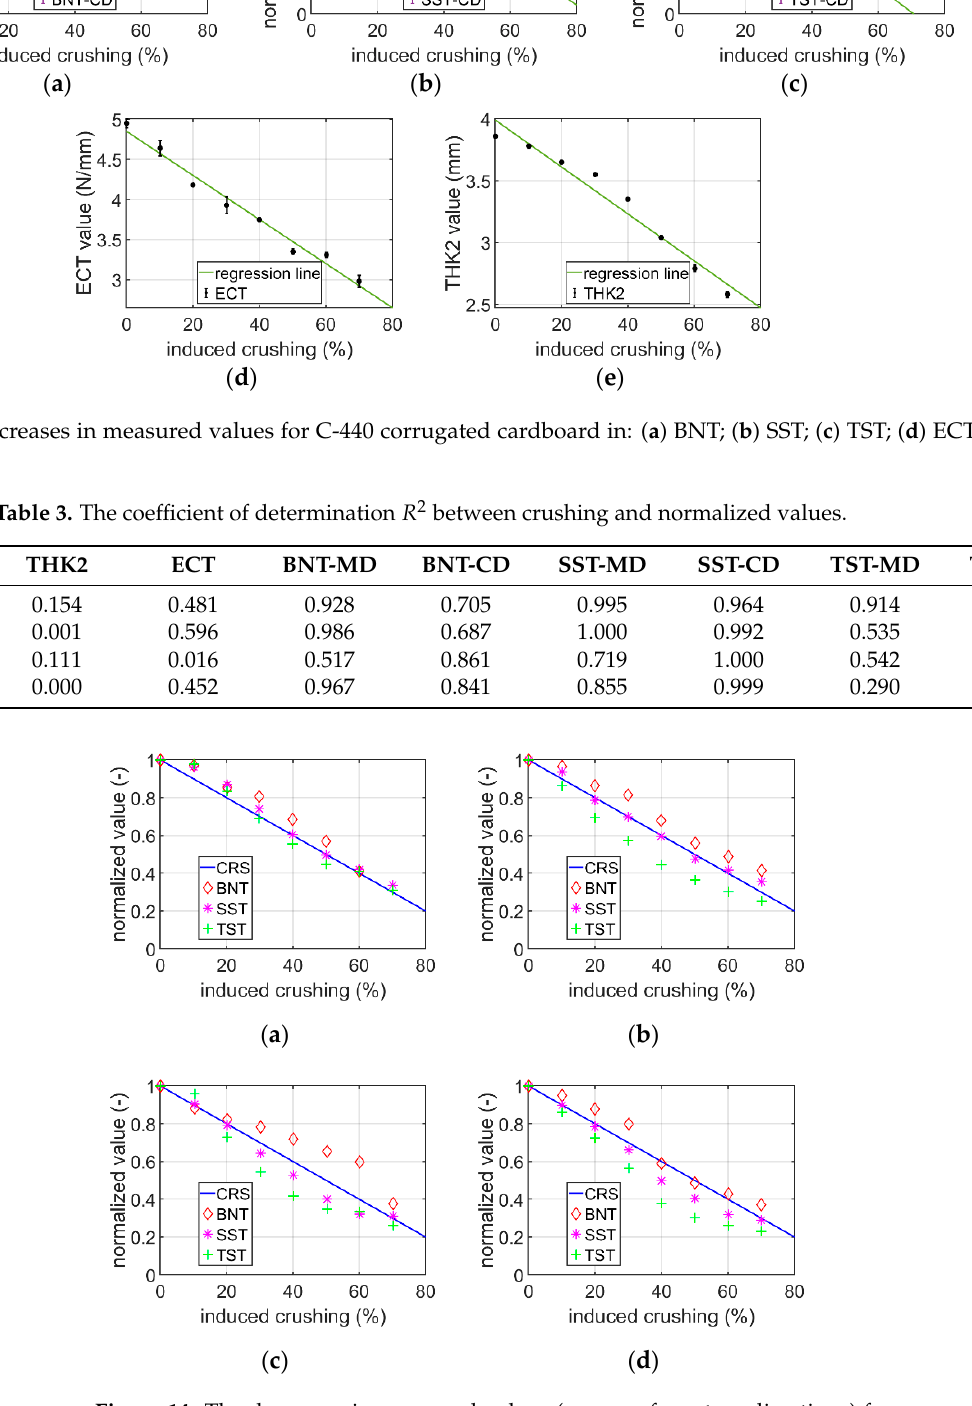
Figure 14. The decreases in measured values (average from two directions) for corrugated board with an index: ( a ) B ‐ 285; ( b ) B ‐ 410; ( c ) C ‐ 340 and ( d ) C ‐ 440. Table 4. The coefficient of determination 𝑅 (cid:2870) between crushing and average normalized values.